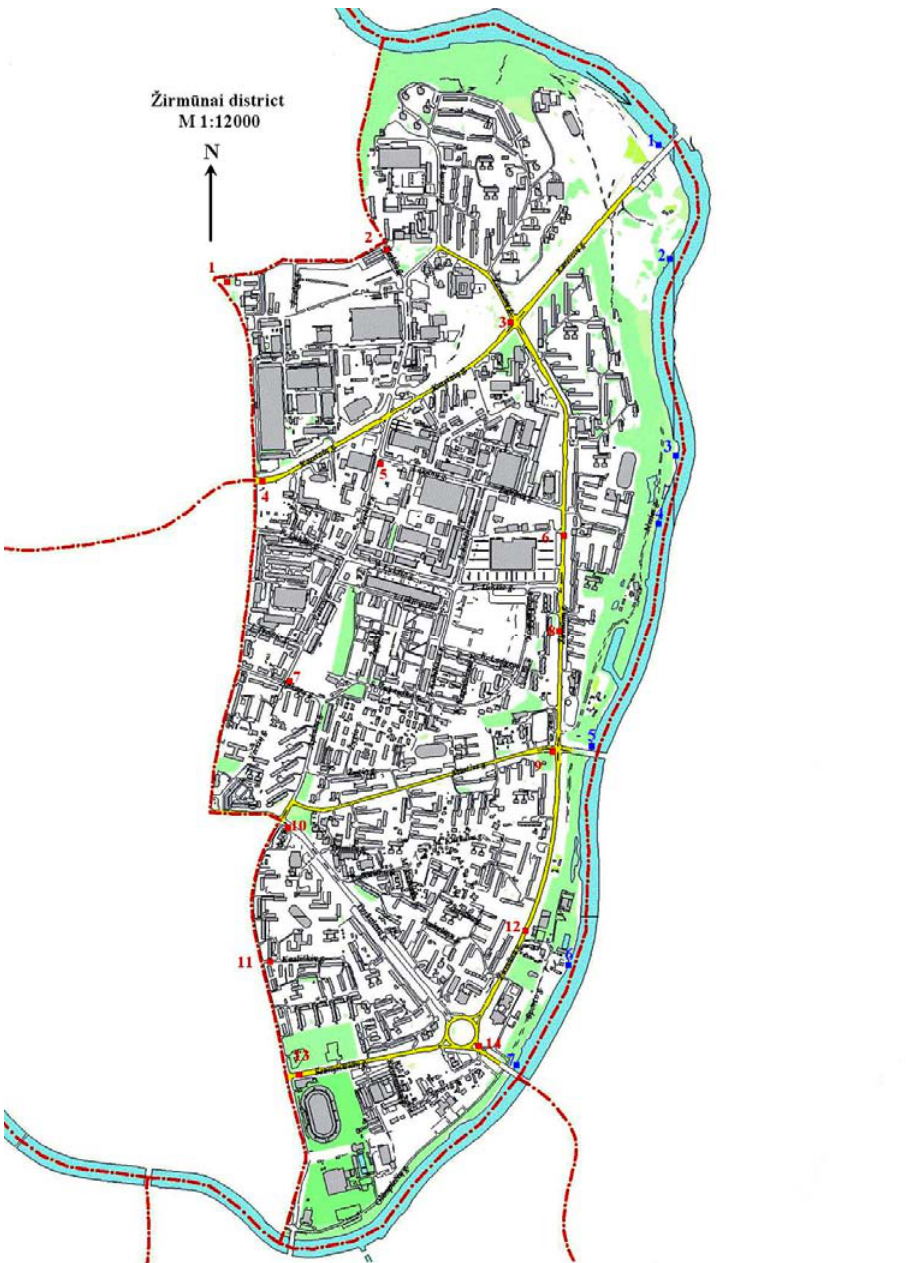
Fig. 1 . Sampling points in Žirm ū nai district. 1, 2 etc. – the highest intensity transport points (samples of sweeps); 5, 7 etc. – outflow number (samples of storm